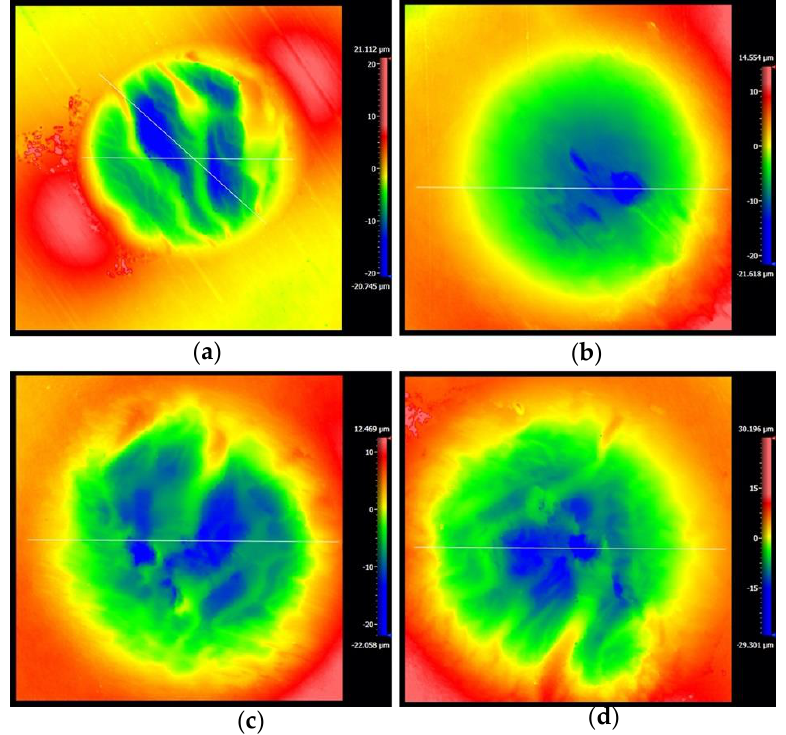
Figure 19. The 3D shape of PVDF thin films with F n = 50 N, D = ±20 μm and ƒ = 15 Hz: ( a ) 0 V, ( b ) 3 V, ( c ) 6 V, and ( d ) 9 V.